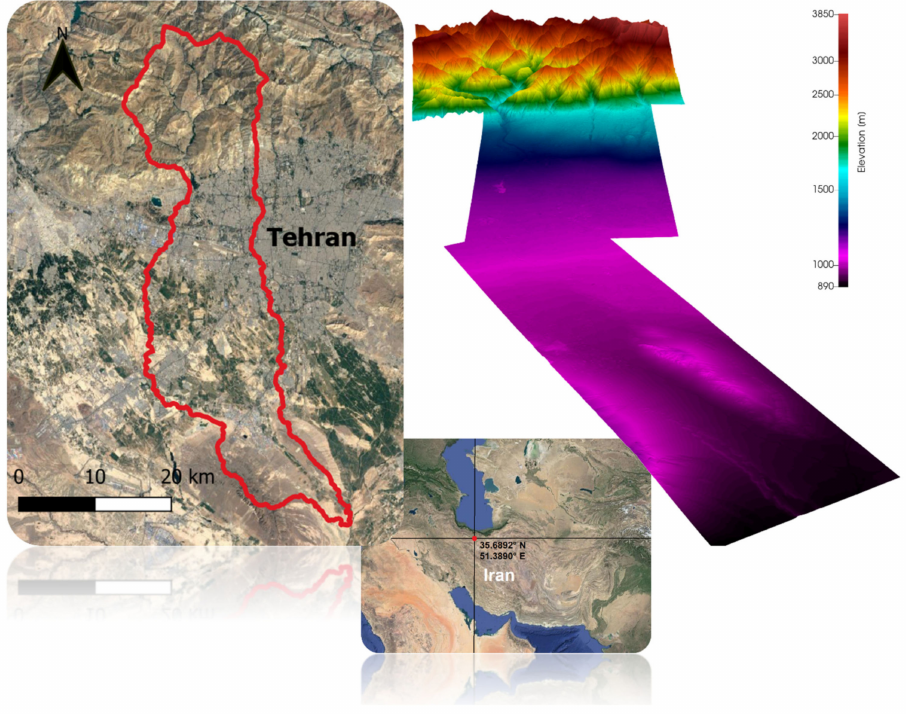
Figure 1. The Kan catchment. The red line shows the boundary of the catchment, noting that the flow is South of the Alborz Mountains range, just South of the Caspian